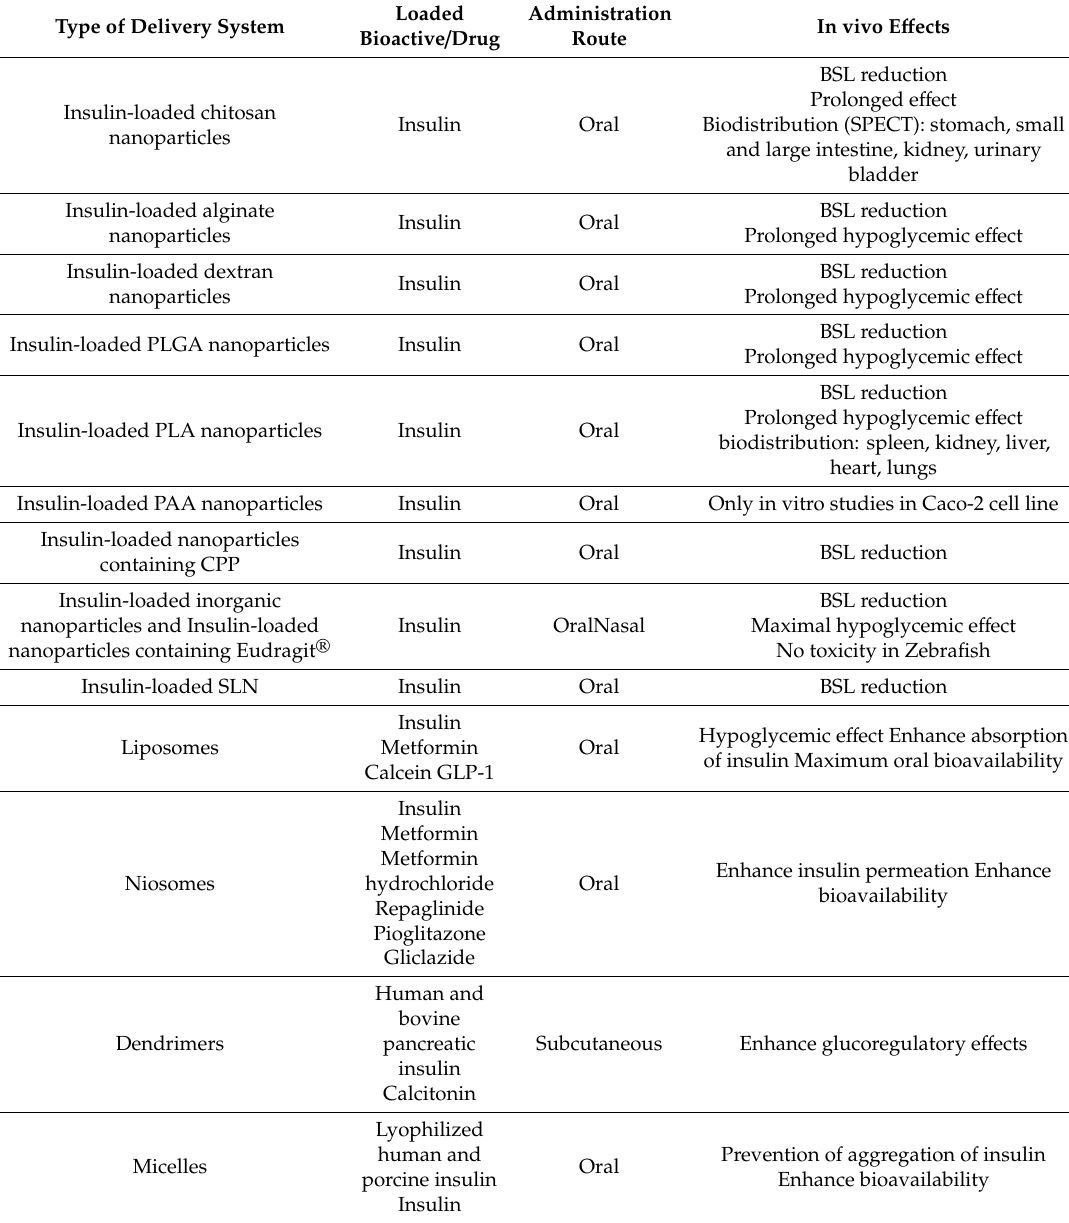
Table A1. Nanoparticulate delivery systems described for the treatment of Diabetes